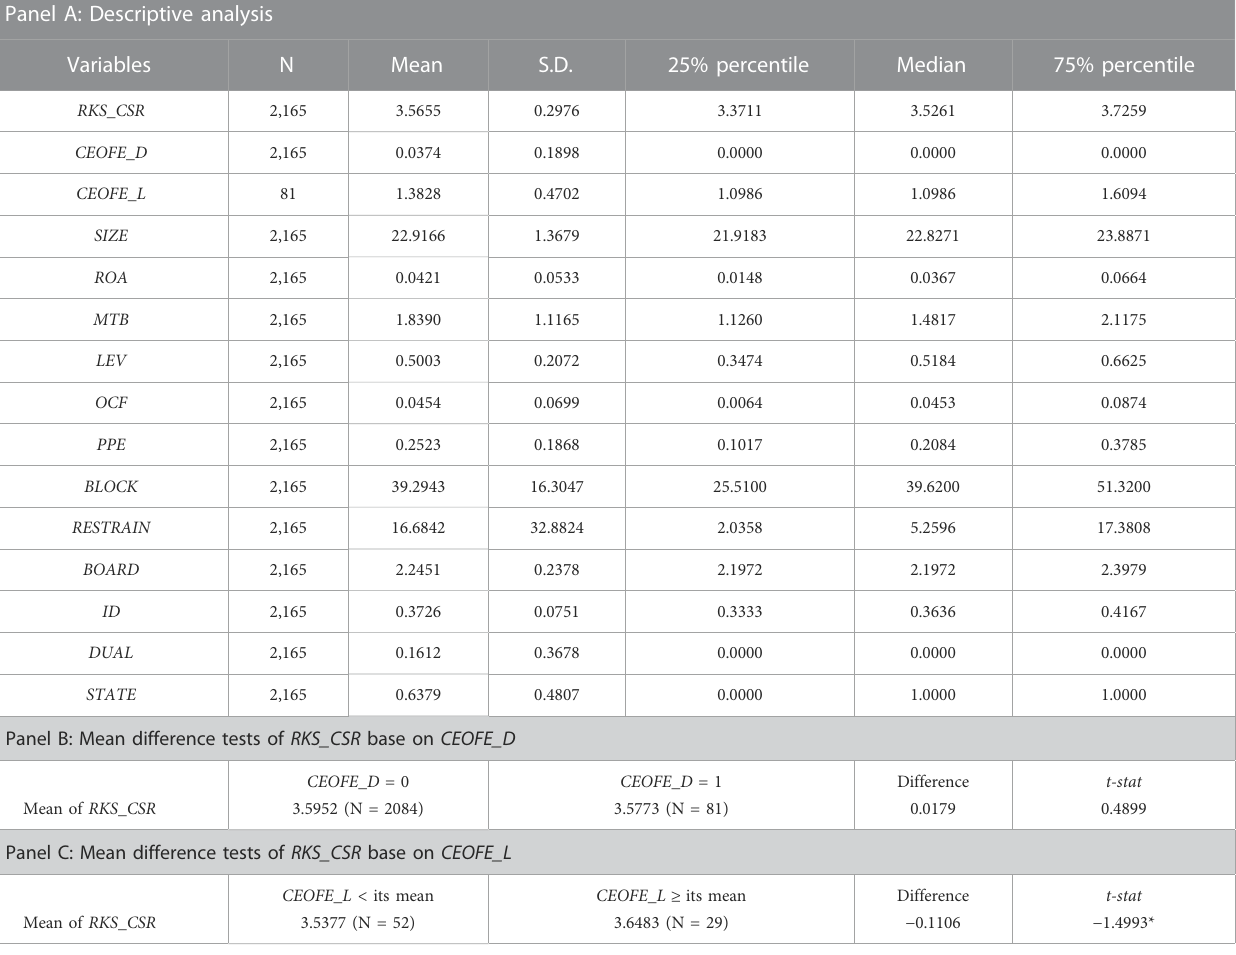
TABLE 2 Summary statistics. Panel A: Descriptive